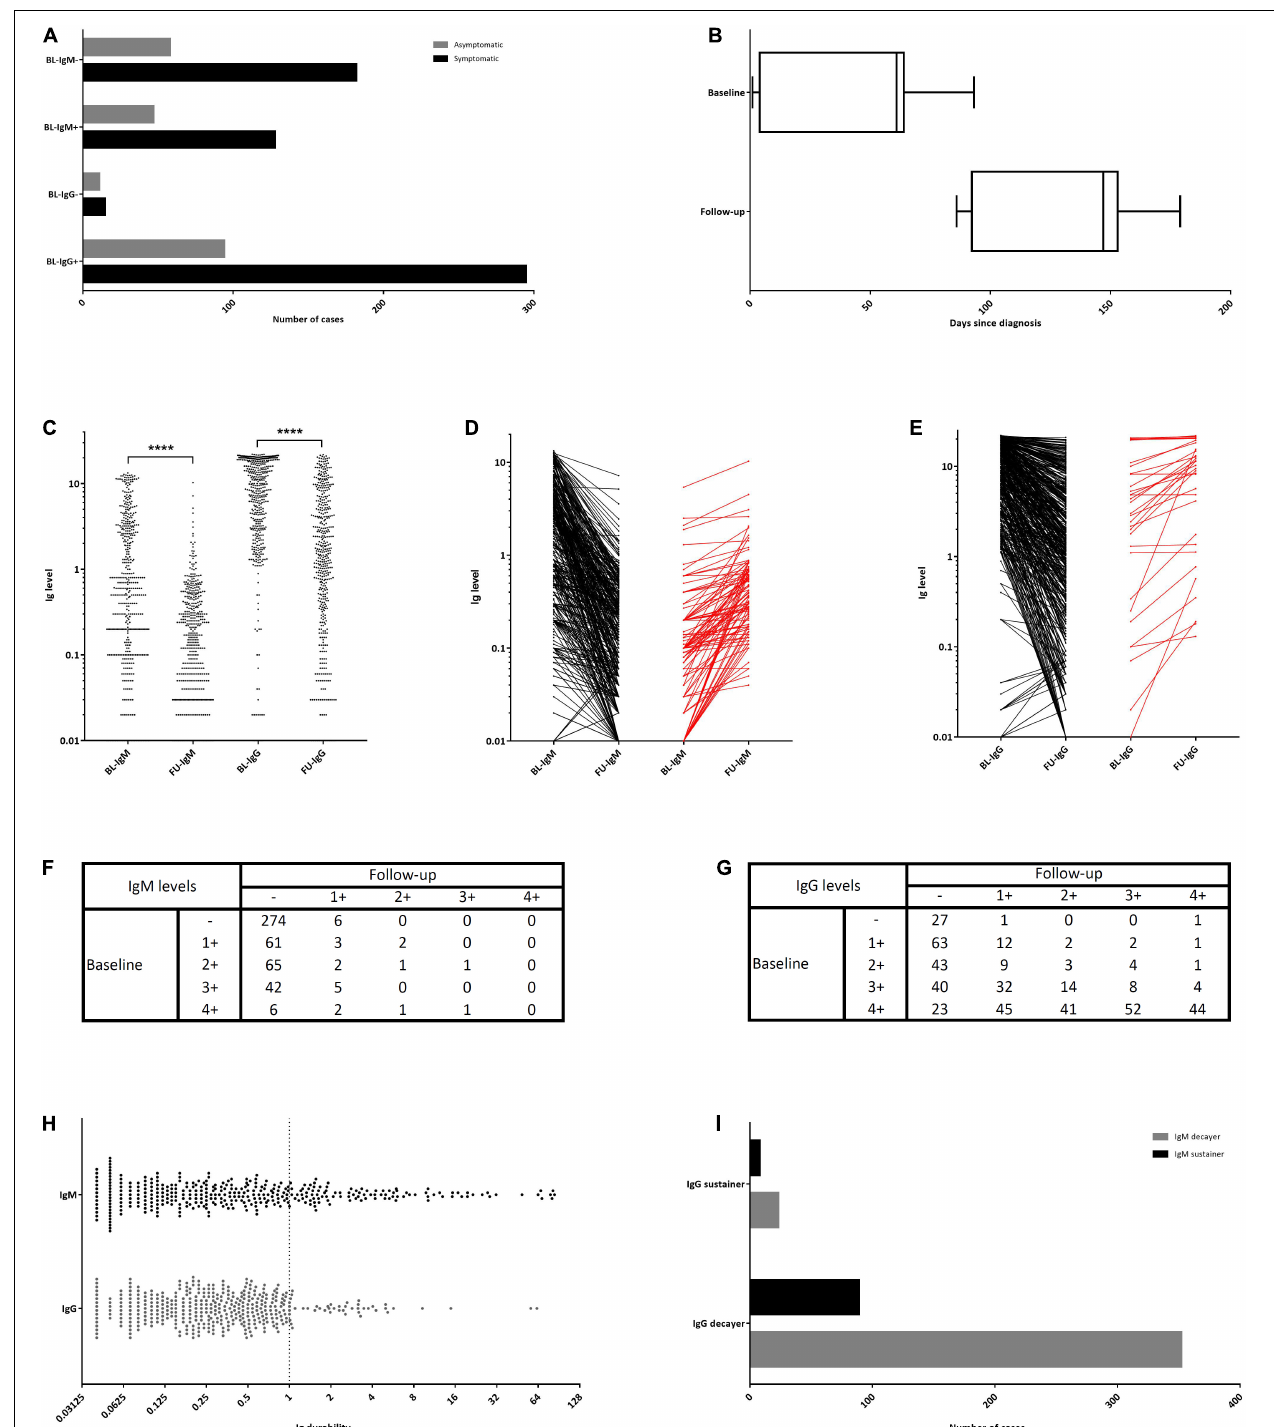
FIGURE 1 | The time course of the baseline (BL) and follow-up (FU) blood sampling and the dynamics of the anti-SARS-CoV-2 seropositivity and symptom changes. (A) The number of symptomatic and asymptomatic subjects in each IgM/IgG negative/positive subgroup. (B) The time-course of the baseline as well as the FU interview and serologic testing. (C) IgM and IgG antibody levels at the baseline and FU. (D) The extent of antibody level change in IgM decayers (black) and IgM sustainers (red). (E) The extent of antibody level change in IgG decayers (black) and IgG sustainers (red). (F) The extent of IgM level change in semiquantitative form. (G) The extent of IgG level change in semiquantitative form. (H) IgM and IgG durability. (I) The number of IgM and IgG sustainers and decayers. (– [negative]: < 1.10, 1+: 1.10–2.99, 2+: 3.00–5.99, 3+: 6.00–11.99, and 4+: ≥ 12.00). ****unpaired two-tailed Student’s t -test, P < 0.0001.